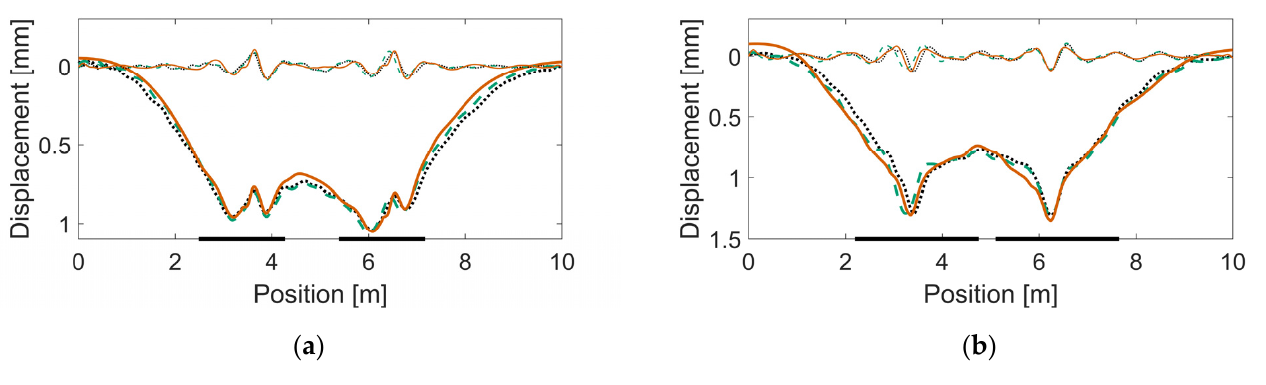
Figure 17. Calibration results showing measured and simulated sleeper displacements (full signals, thick line; and band-